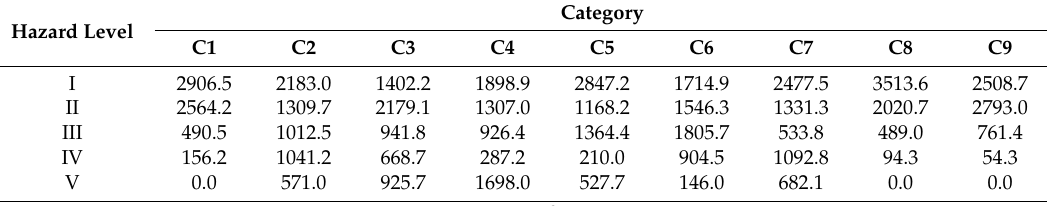
Table 4. The areas of the SACZs corresponding to each hazard level and typhoon